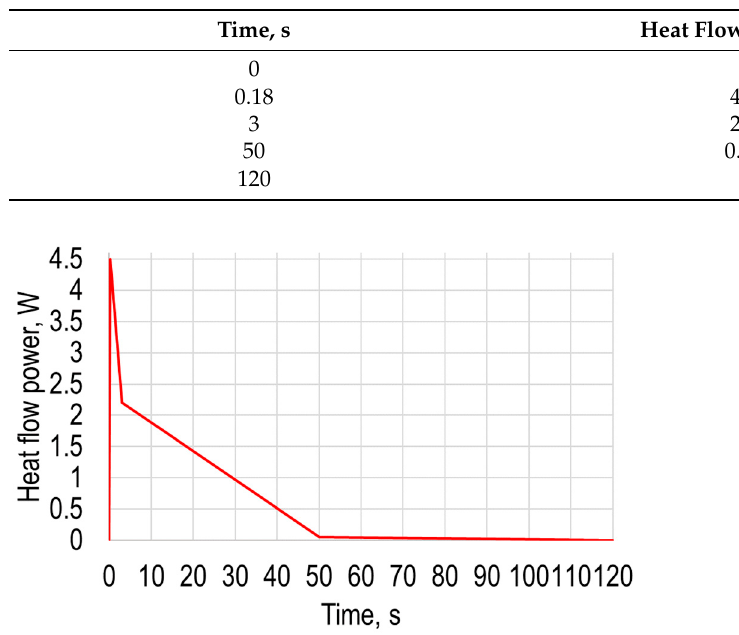
( b ) Figure 10. Transient thermal numerical analysis: ( a ) scheme; ( b ) computational model with boundary conditions. During both stages of the simulation the analysis time was divided into steps. The total time of simulation was 120 s. The time of the first stage was 3 s and this stage was divided into 50 sub steps. The second stage was 120 s, and this stage was divided into 100 sub steps.